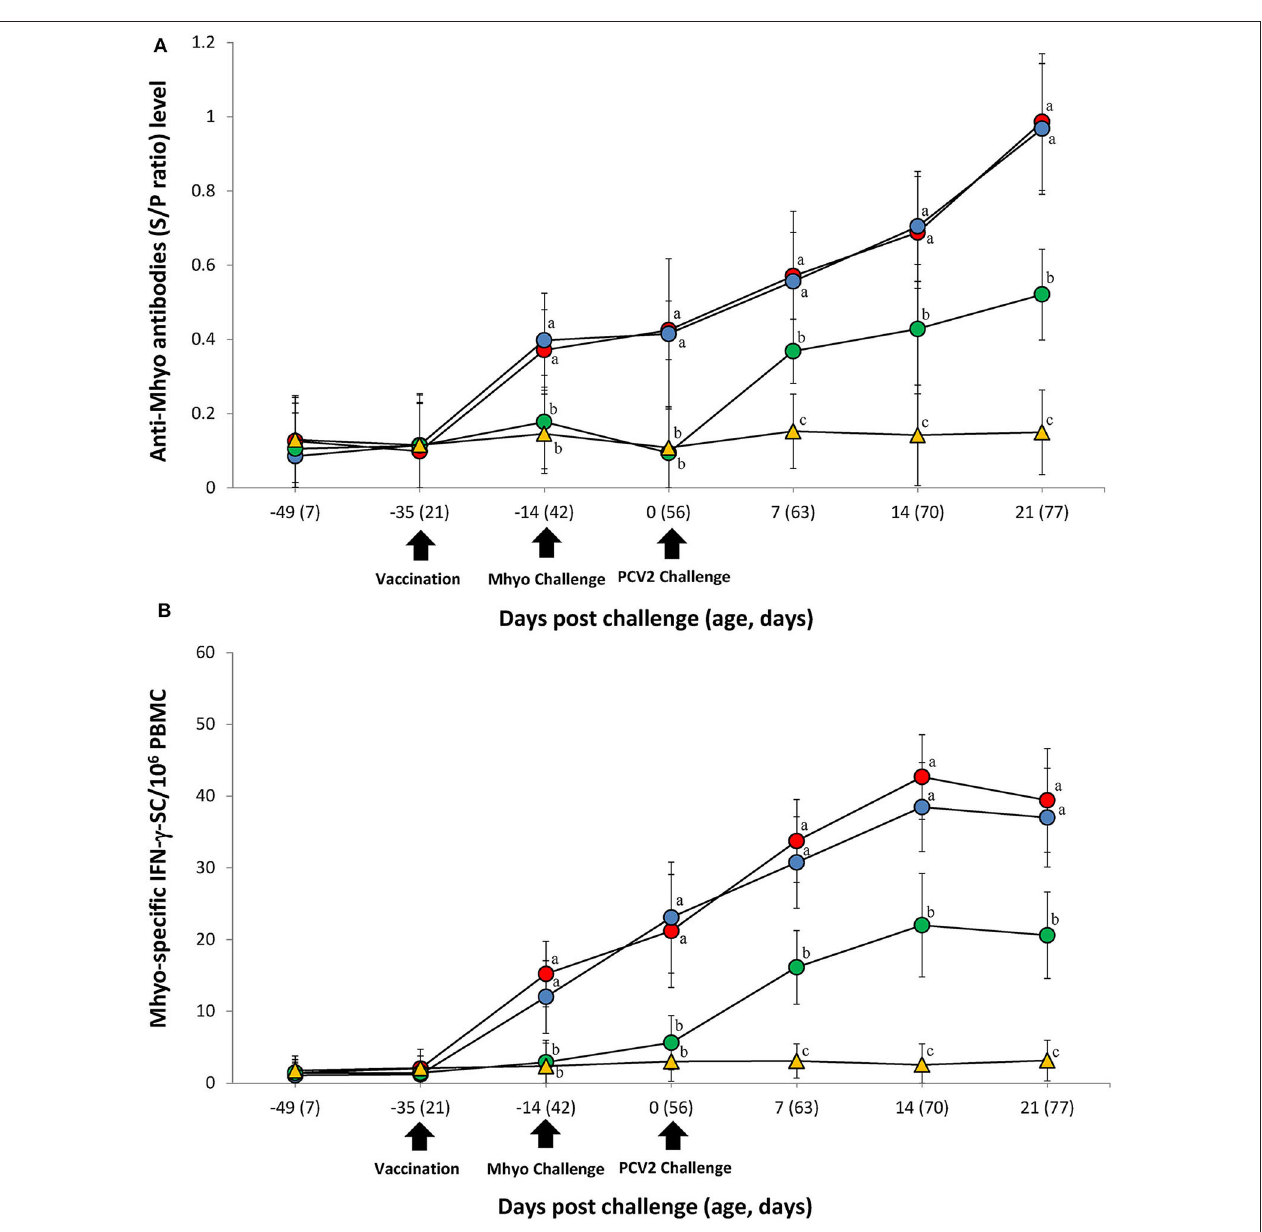
FIGURE 3 | Immune responses against Mycoplasma hyopneumoniae (Mhyo). (A) Mean values of the Mhyo ELISA antibodies. (B) Frequency of Mhyo-specific interferon- γ secreting cells (IFN- γ -SC)/10 6 peripheral blood mononuclear cells (PBMC) in the different groups: VacA/Ch (•), VacB/Ch (•), UnVac/Ch (•), and UnVac/UnCh ( N ). Variation is expressed as the standard deviation. Different letters within a sampling point mean statistically significant differences ( P < 0.05).